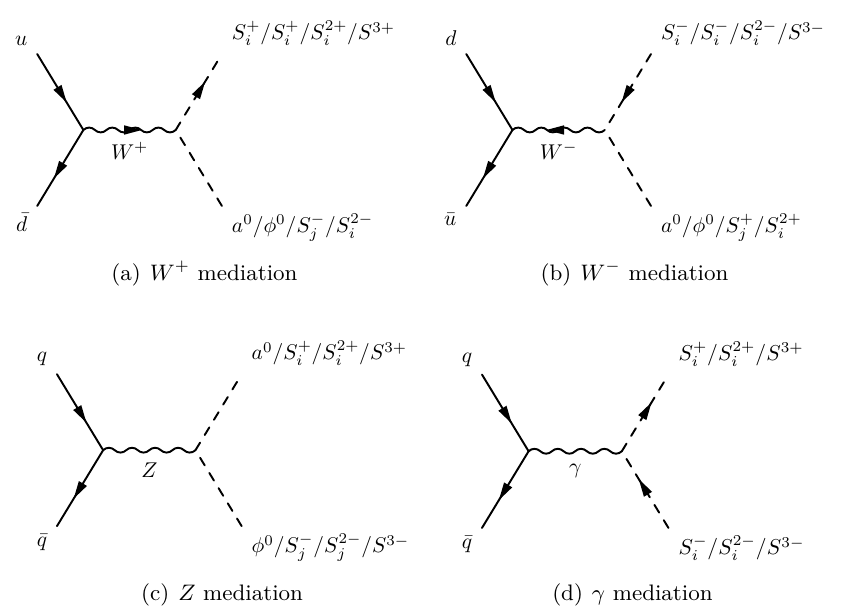
Figure 4 . Typical Feynman diagrams for the scalar pair production at pp colliders, including W + - mediated u + ¯ d → S +